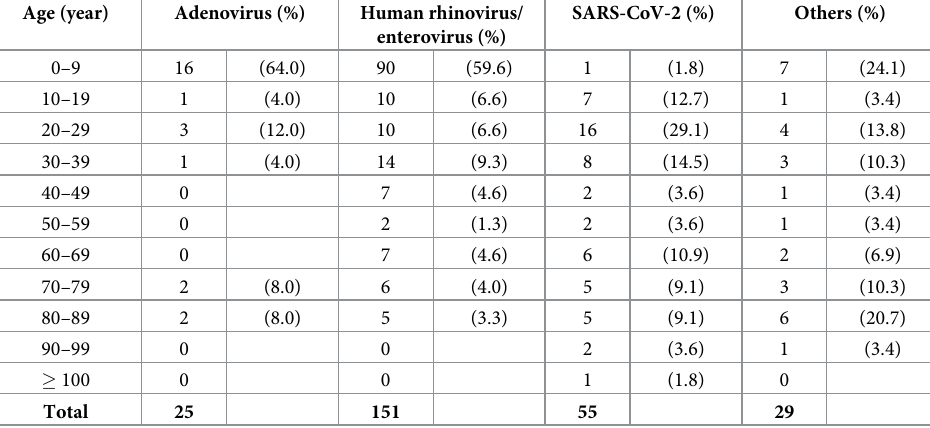
Table 2. Distribution of detected pathogens by